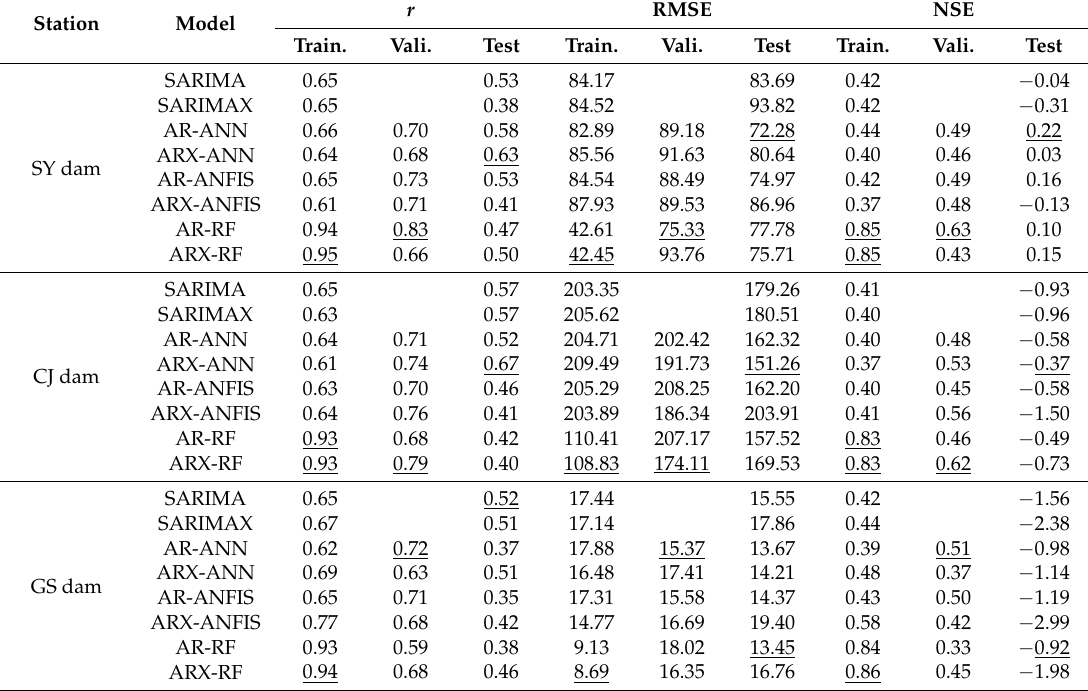
Model performance of the SARIMA, SARIMAX, AR-ANN, ARX-ANN, AR-ANFIS, ARX-ANFIS, AR-RF, and ARX-RF models during the training, validation, and test periods for the SY, CJ, and GS